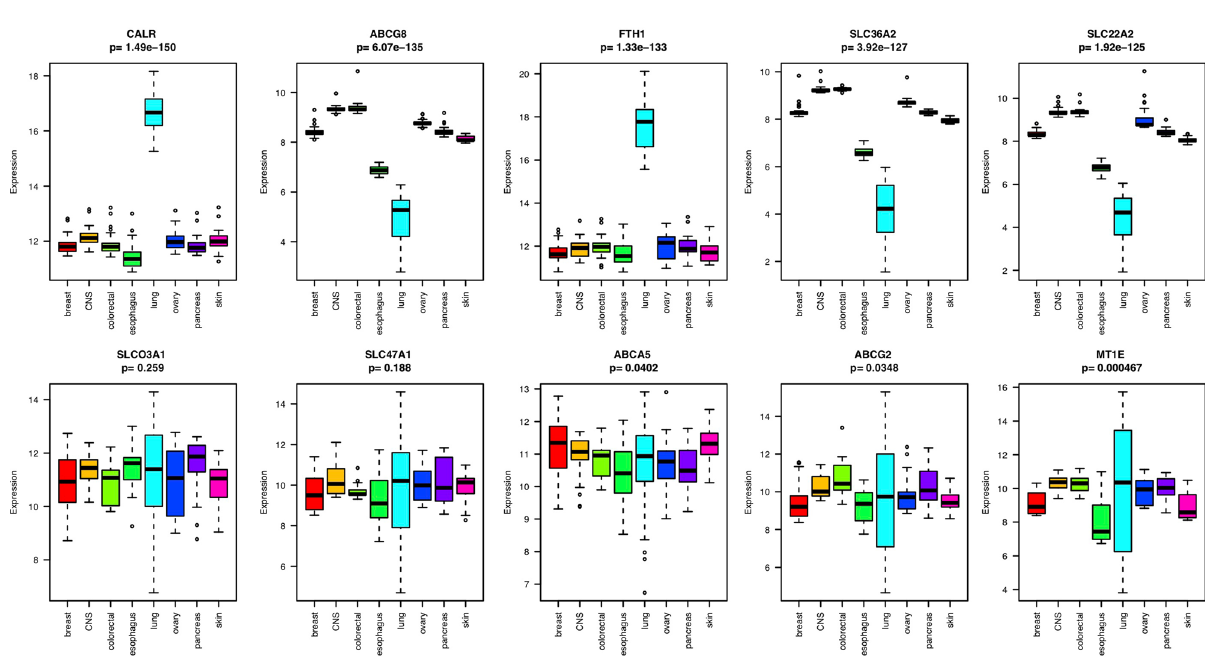
Figure 3. Boxplot of the gene expression of the ten transporters that showed the strongest or weakest lineage- specific distribution in eight different tissue types, each with more than ten cell